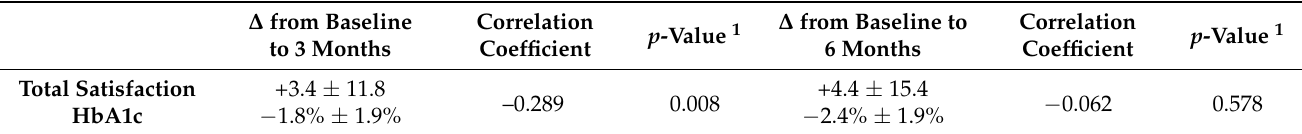
Table 4. Correlation between mean change in total patient satisfaction and mean change in HbA1c over time (n = 83), mean ±